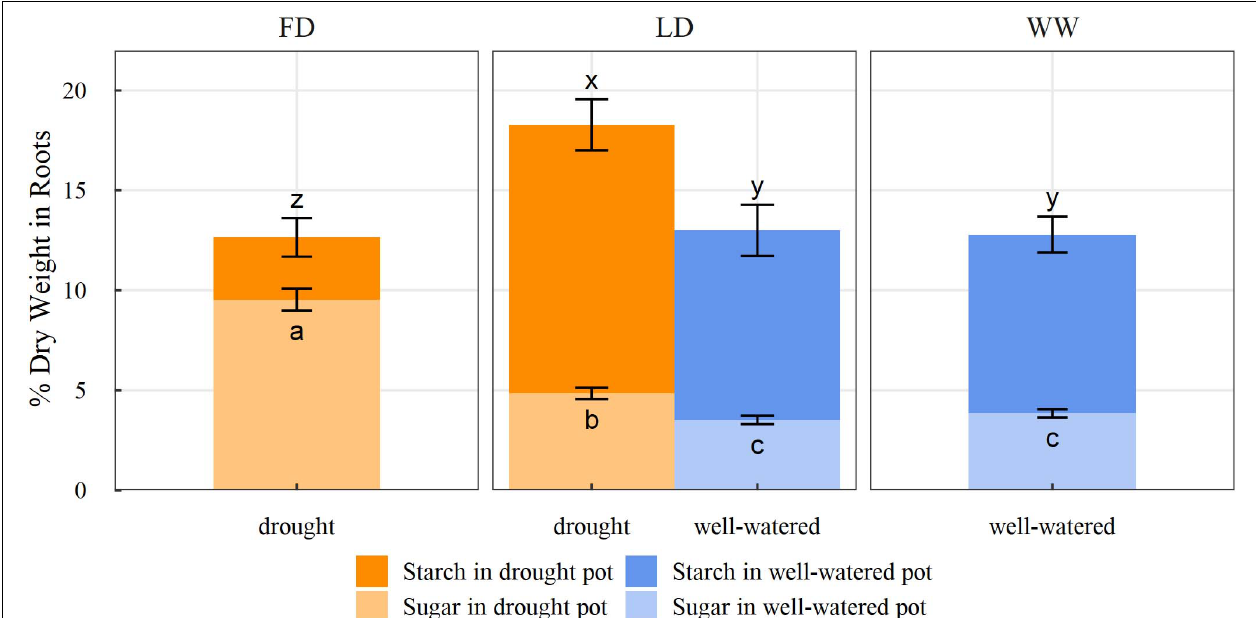
FIGURE 3 | Estimated marginal means ( ± 1 standard error) of root starch and soluble sugar concentration (% of dry weight) within the split root systems of saplings subjected to three watering treatments (FD: full drought, LD: localized drought, WW: well-watered), (light orange: sugar concentration of roots in drought pot, dark orange: starch concentration of roots in drought pot, light blue: sugar concentration of roots in well-watered pot, dark blue: starch concentration of roots in well-watered pot). Letters indicate statistical differences among treatments and pot watering regimes ( n = 29; α = 0.1) using pairwise comparisons with a Benjamini-Hochberg